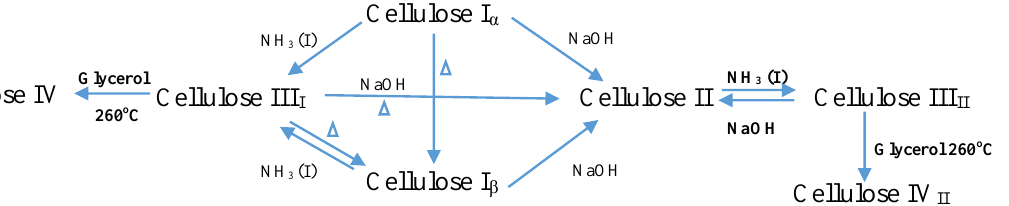
Figure 1. Schematic diagram of polymorph synthesize of cellulose.